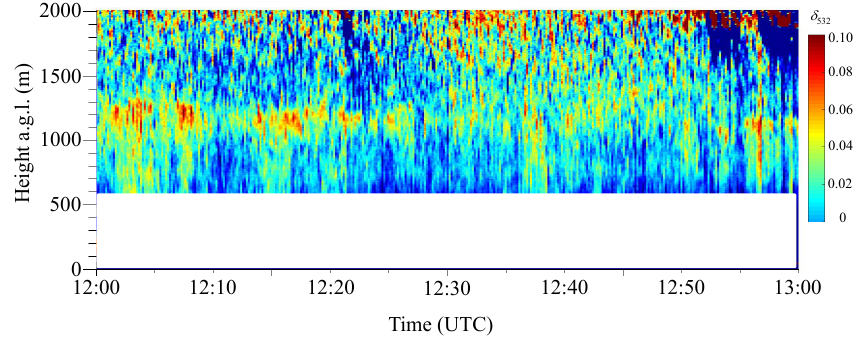
Figure 5. Time–height cross-section of particle depolarisation at 532nm in the time interval 12:00–13:00UTC on 18 April 2013.